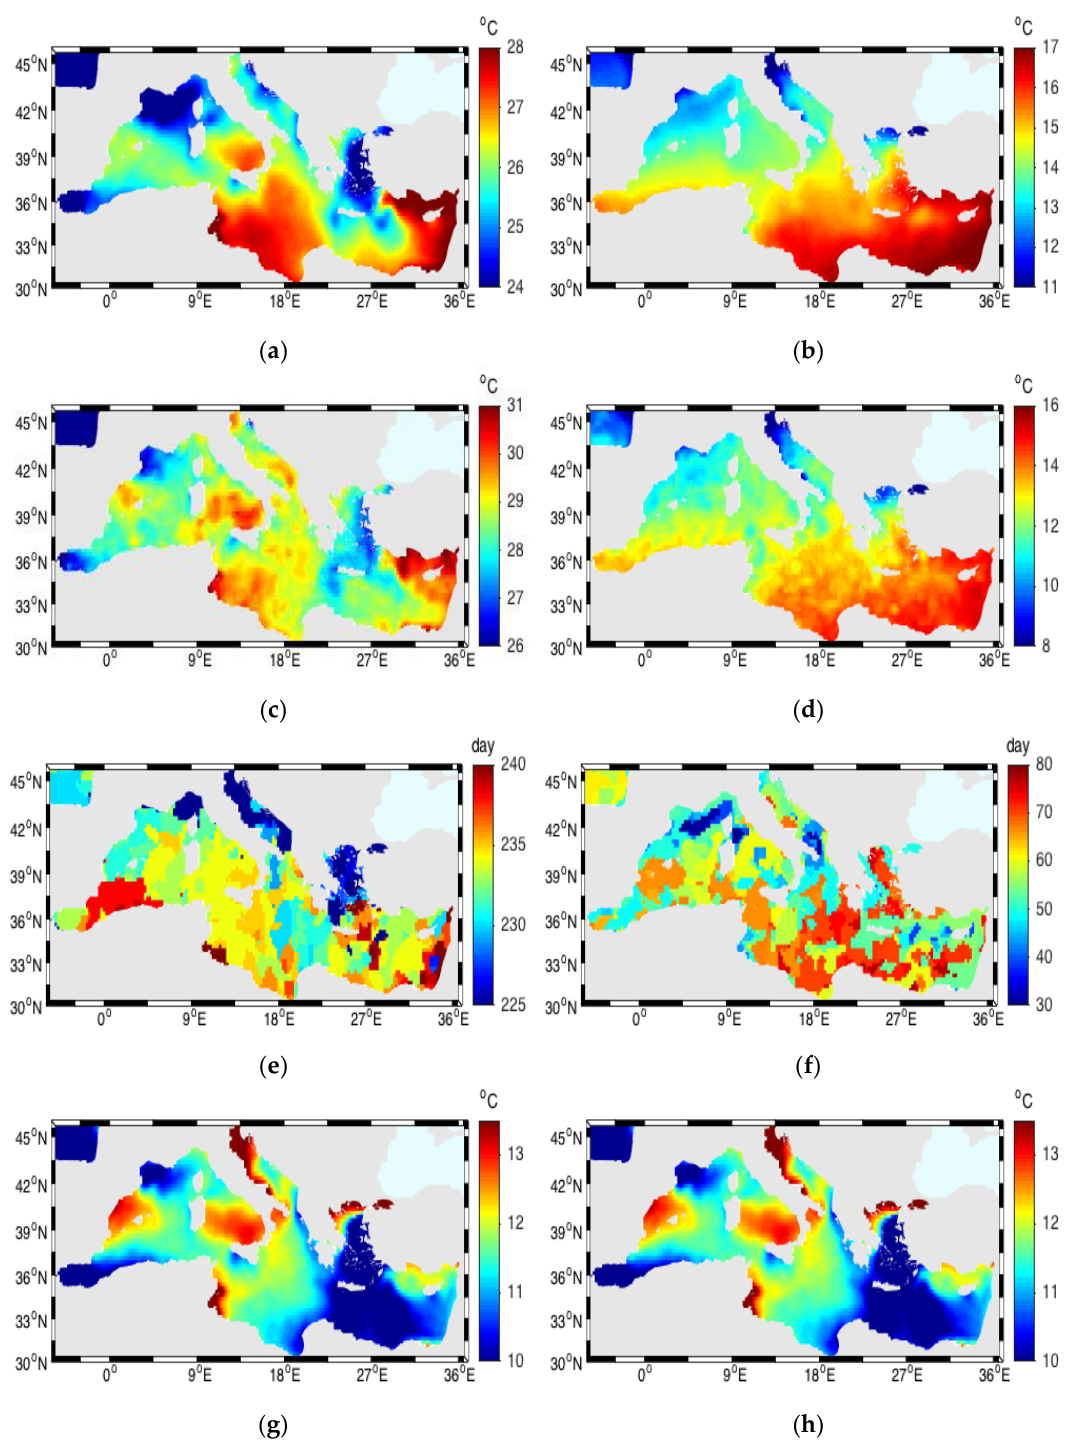
Figure 3. Annual cycle of SST in the MEDIT based on the dOISST.v2 data (1982 – 2017): ( a ) annual maximum SST averaged in 36 years; ( b ) annual minimum SST averaged in 36 years; ( c ) maximum SST observed during the 36-year time interval; ( d ) minimum SST observed during the 36-year time interval; ( e ) day of year when the maximum SST is observed; ( f ) day of year when the minimum SST is observed; ( g ) annual amplitude of SST annual cycle averaged in 36 years; ( h ) standard deviation (STD) in SST anomalies. STD was calculated for each pixel from daily SST data after subtracting the 36 years average daily SST value and long term trend at each pixel.